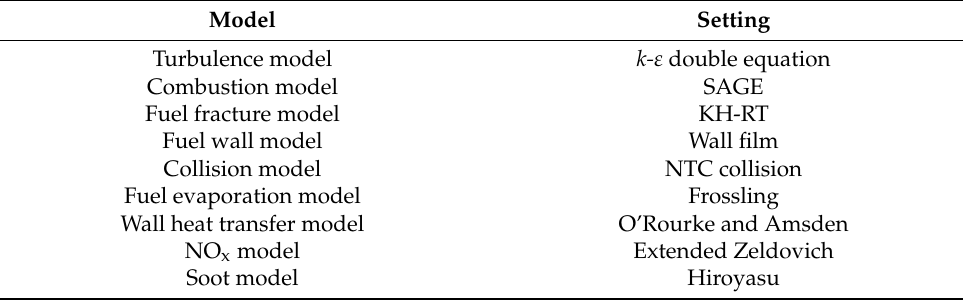
Table 3. Selection of each submodel.